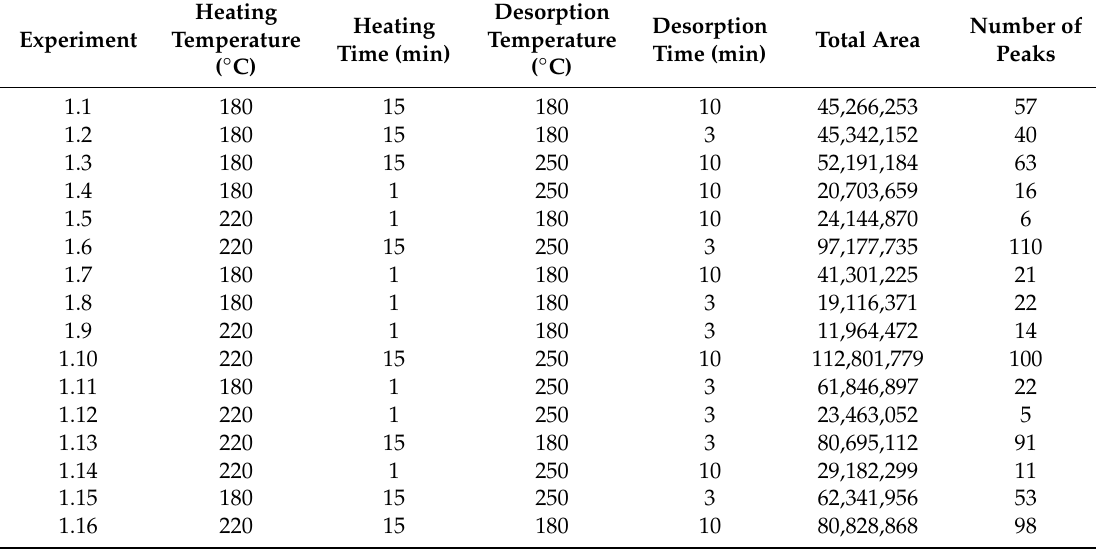
Table 2. Conditions, total area and number of chromatographic peaks obtained in each experiment of the 2 4 factorial design.